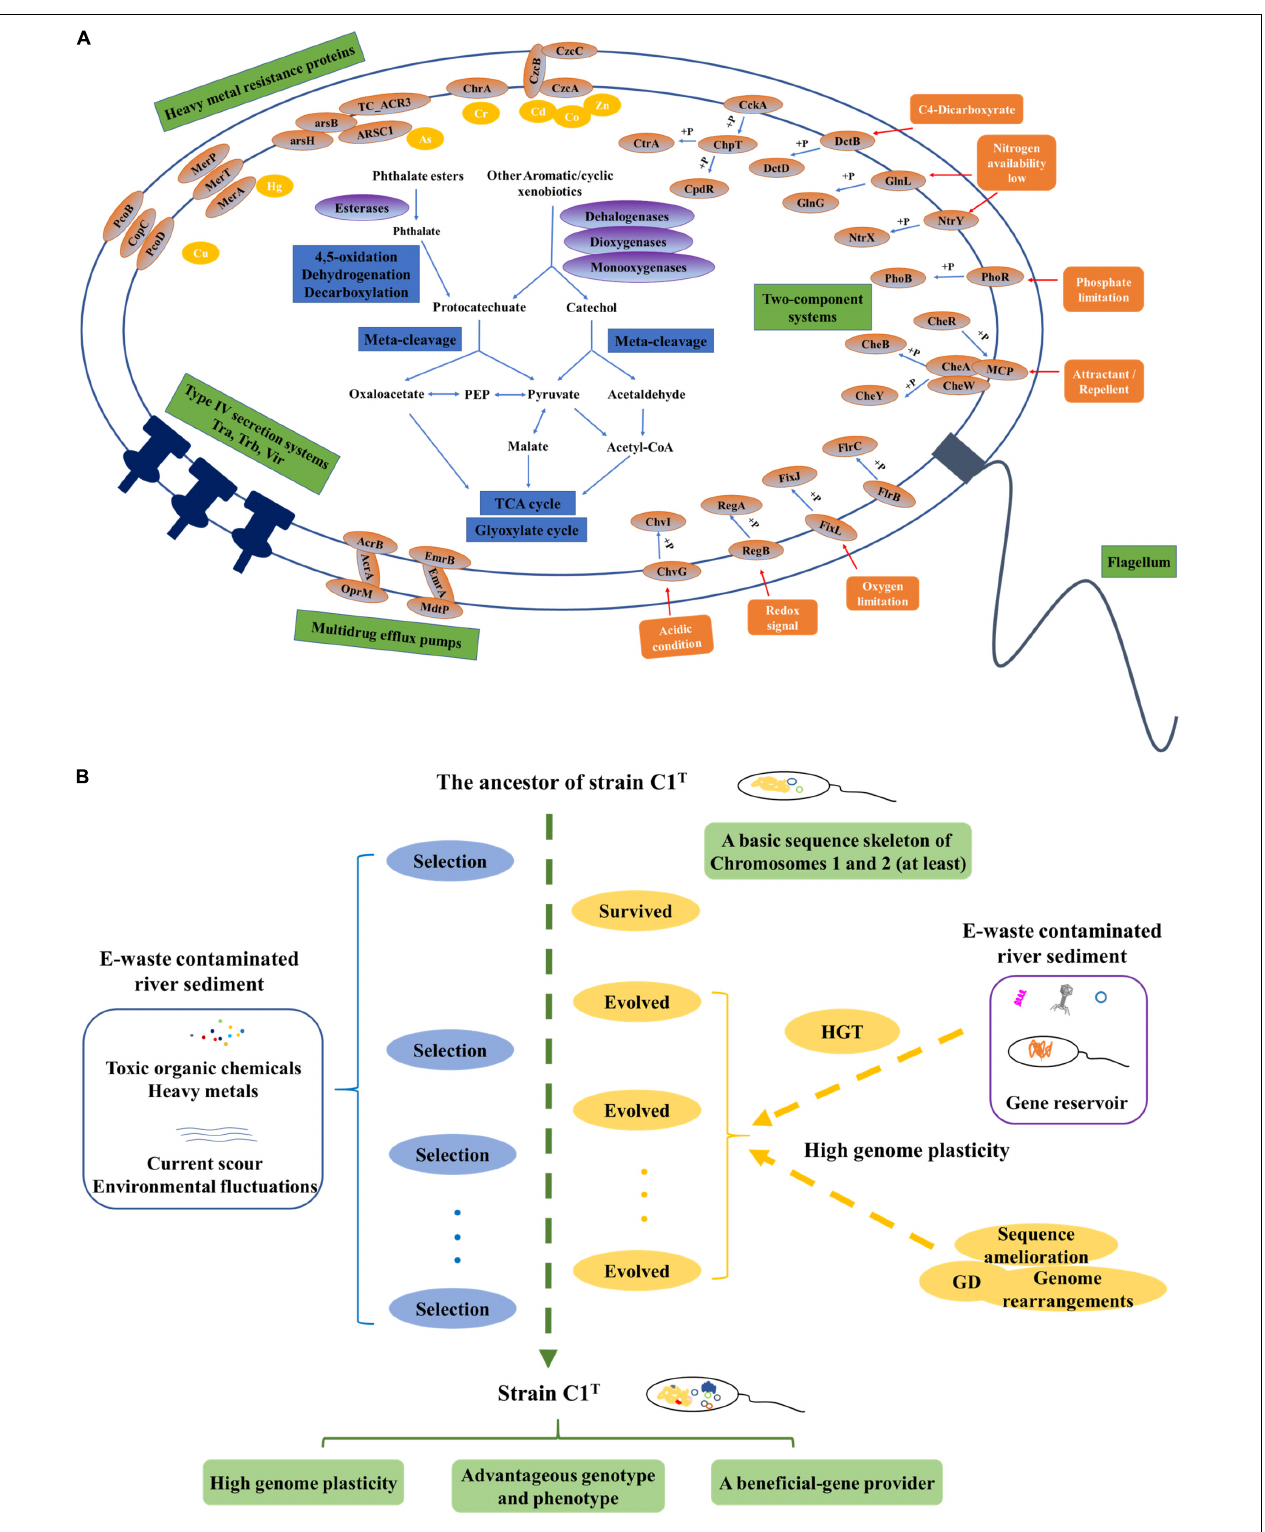
FIGURE 8 | The adaptive evolution of strain C1 T in e-waste contaminated river sediment. (A) A brief metabolic reconstruction of strain C1 T . The physiological processes and proteins involved in xenobiotic degradation, heavy metal resistance, environmental response and conjugational transfer are shown. (B) A conceptual model of the adaptive evolution process. Positive selection, gene duplication (GD), and especially horizontal gene transfer (HGT) drive the adaptive evolution of strain C1 T . After rounds of selection, strain C1 T obtained a high genome plasticity and advantageous phenotype.